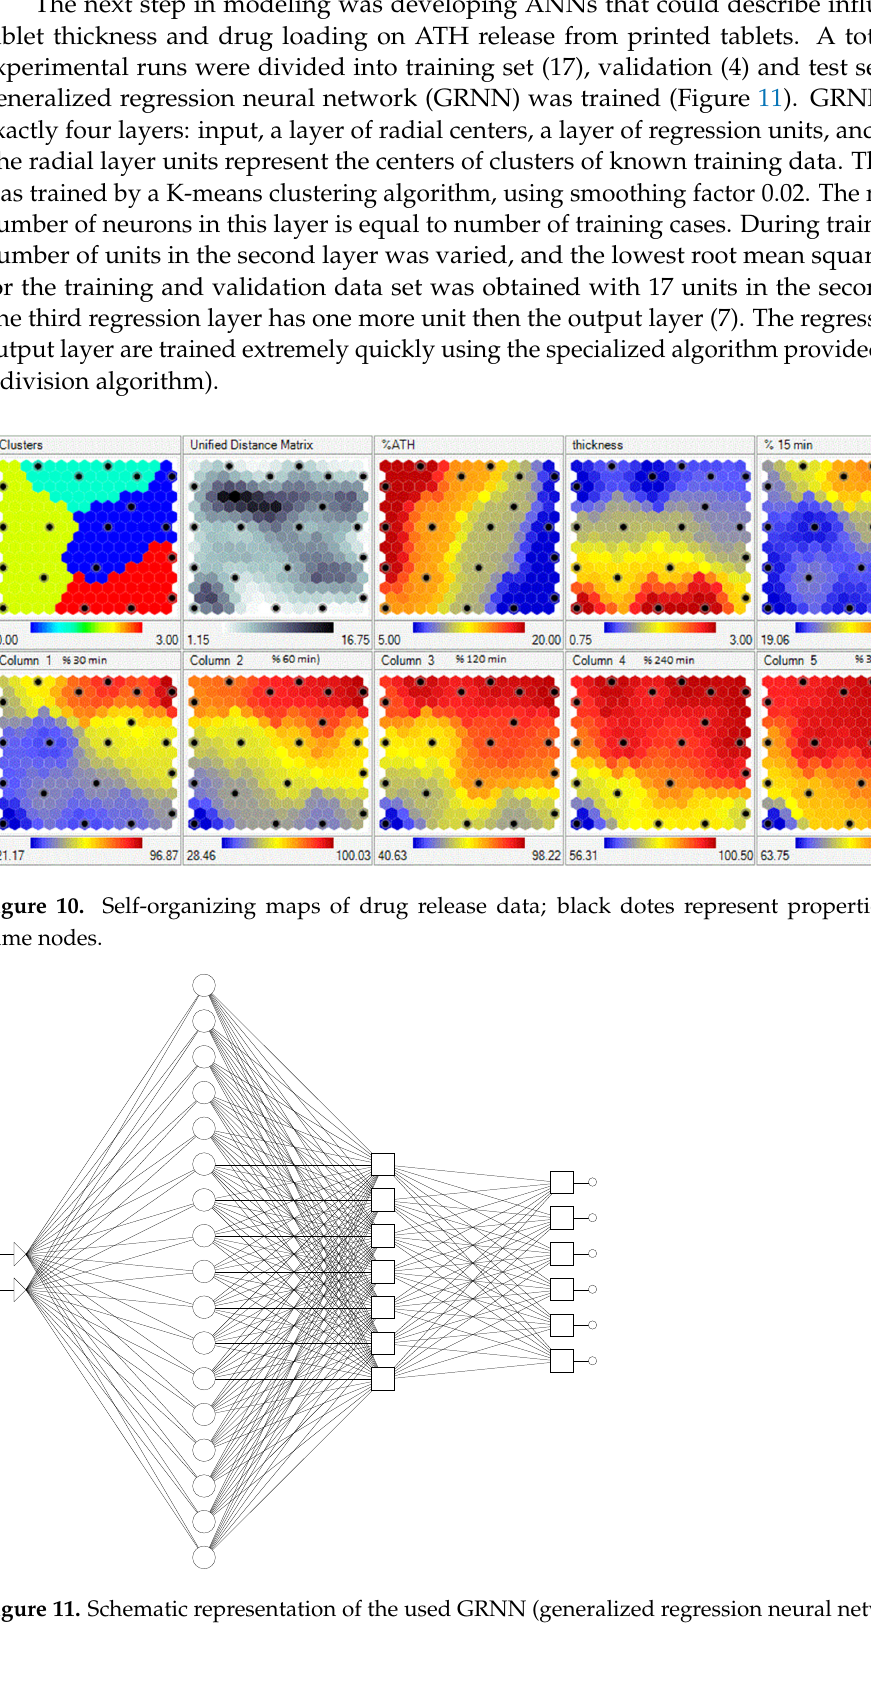
Figure 11. Schematic representation of the used GRNN (generalized regression neural network). After training, values for RMS error were 0.126 for the training set, 0.040 for the val- idation set and 0.035 for the testing set. Response surfaces predicted by GRNN, representing outputs (Y1–Y6 percent of drug released after predetermined time intervals) as a function of tablet thickness and drug loading, are presented in Figure 12a–f. These response surfaces clearly show GRNN pre- dictions of drug release, as a function of tablet thickness and drug loading.